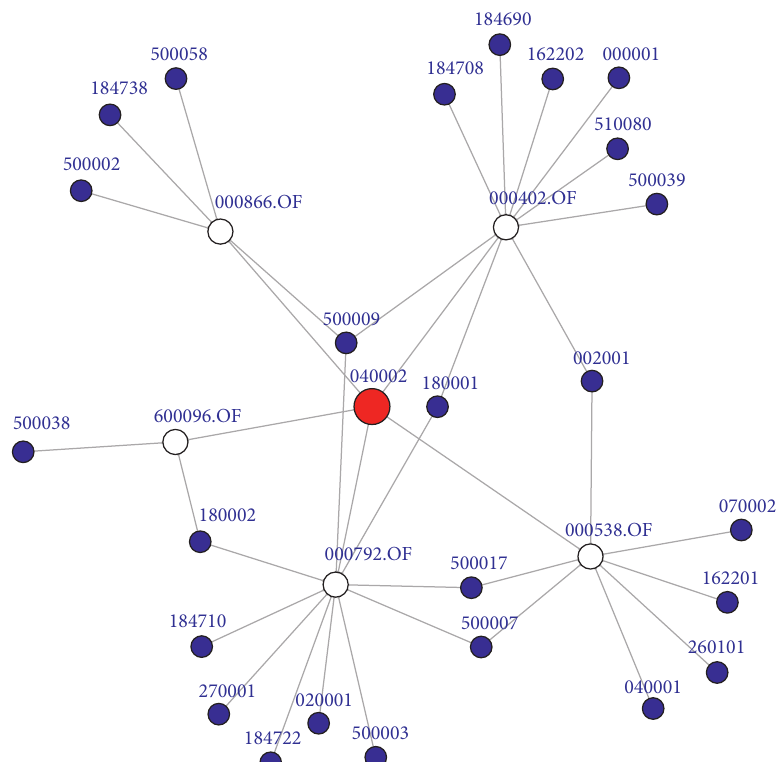
Figure 2: The connections of fund 040002 (the red node) on 31 March